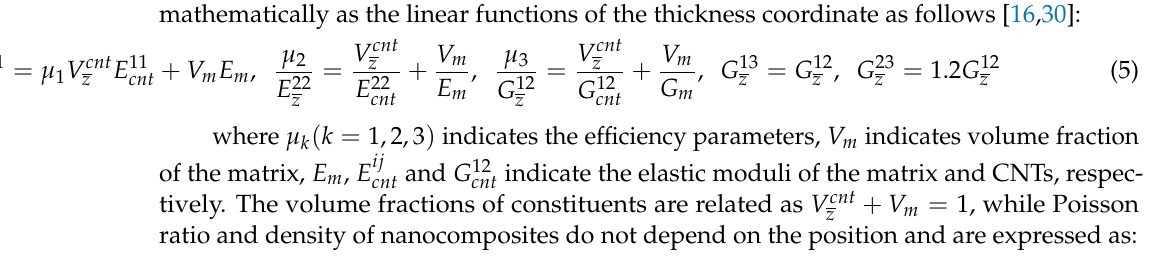
Figure 3. The cross section of CNT patterned construction elements: ( a ) U pattern, ( b ) V pattern, ( c ) O pattern and ( d ) X pattern.